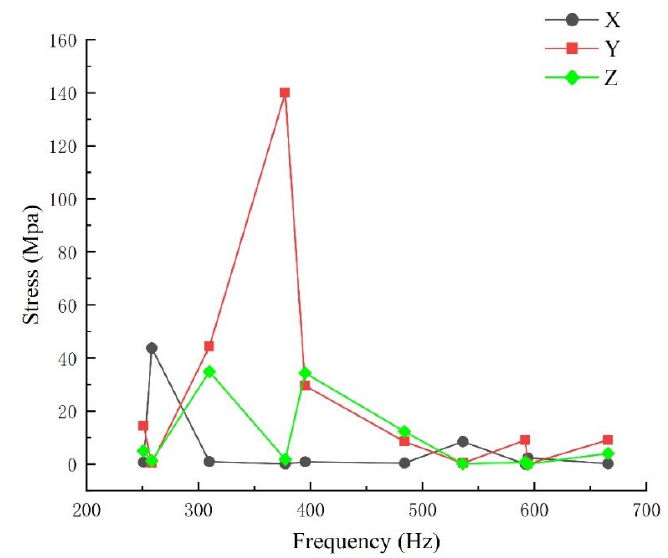
Figure 11. Equivalent stress of the electric control box in the X, Y, and Z directions.